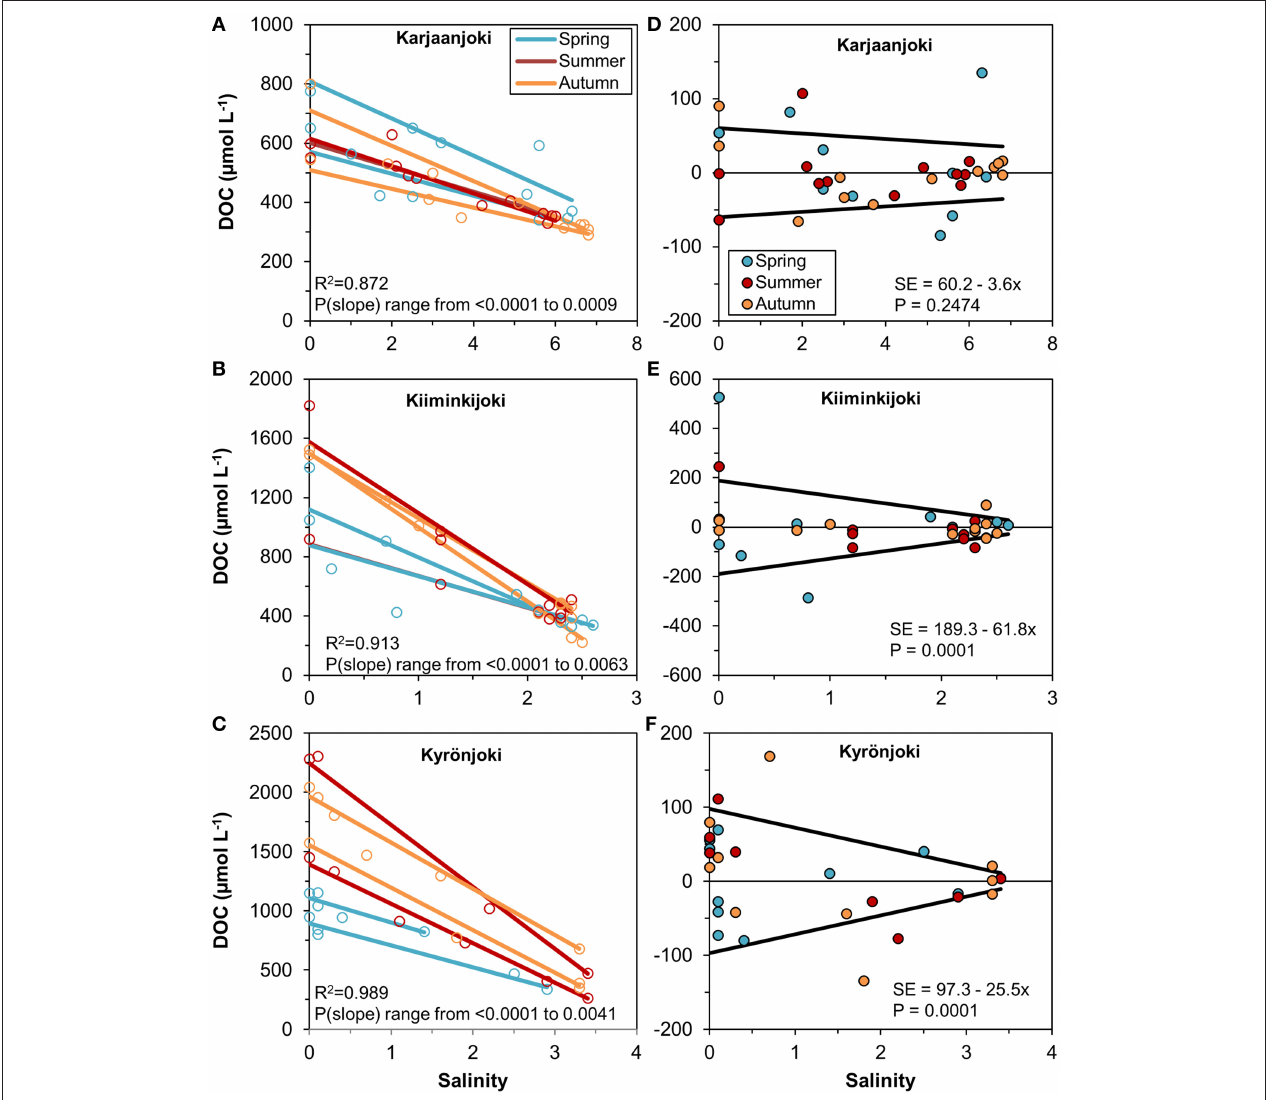
FIGURE 3 | (A–C) Linear regressions between DOC concentration and salinity for each sampling transect, estuary, and season. Observations are shown with open symbols. All slopes are significant ( P < 0.05 ) and the R 2 is for all regressions within the estuary. (D–F) Residuals from the regression models and the estimated models for the residual standard error for the three